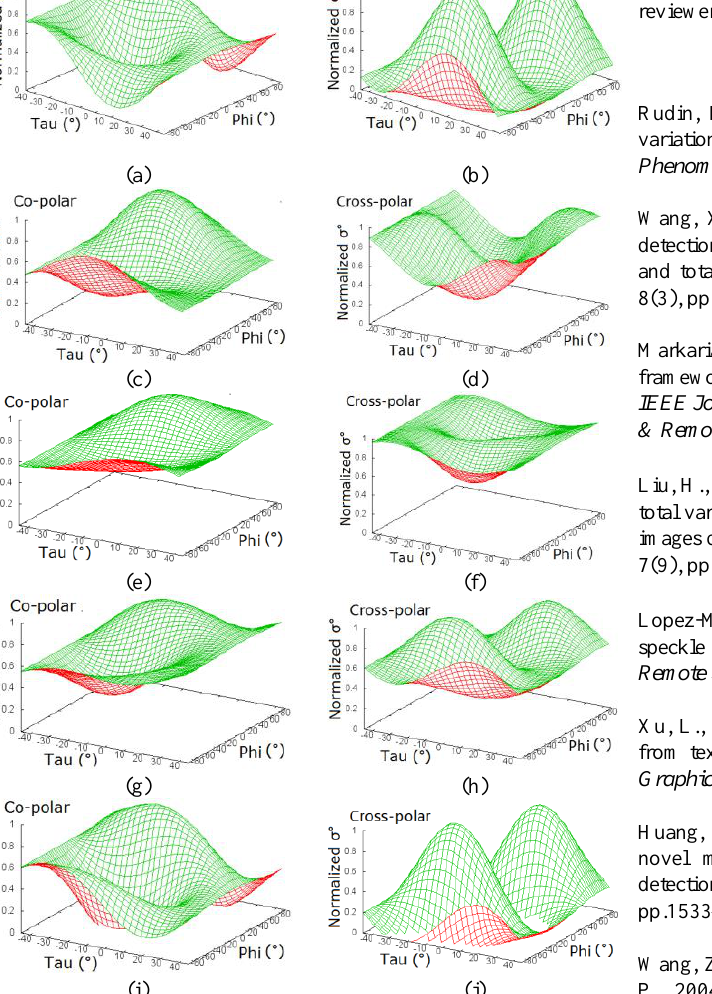
Figure 3. Co-polar and cross-polar polarization signature.(a,b) The original image.(c,d) Boxcar.(e,f) IDAN.(g,h) RefinedLee. (i,j)